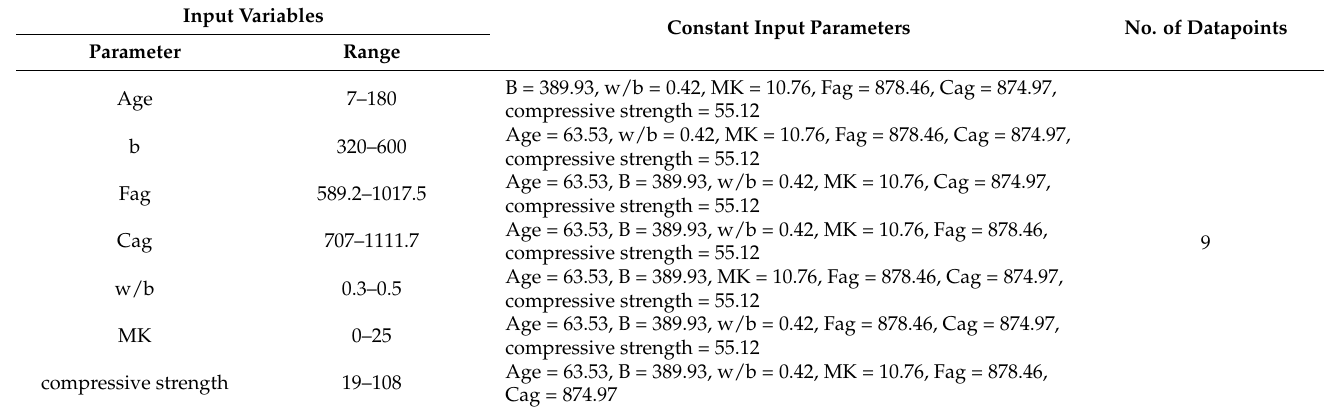
Table 5. Dataset used for parametric